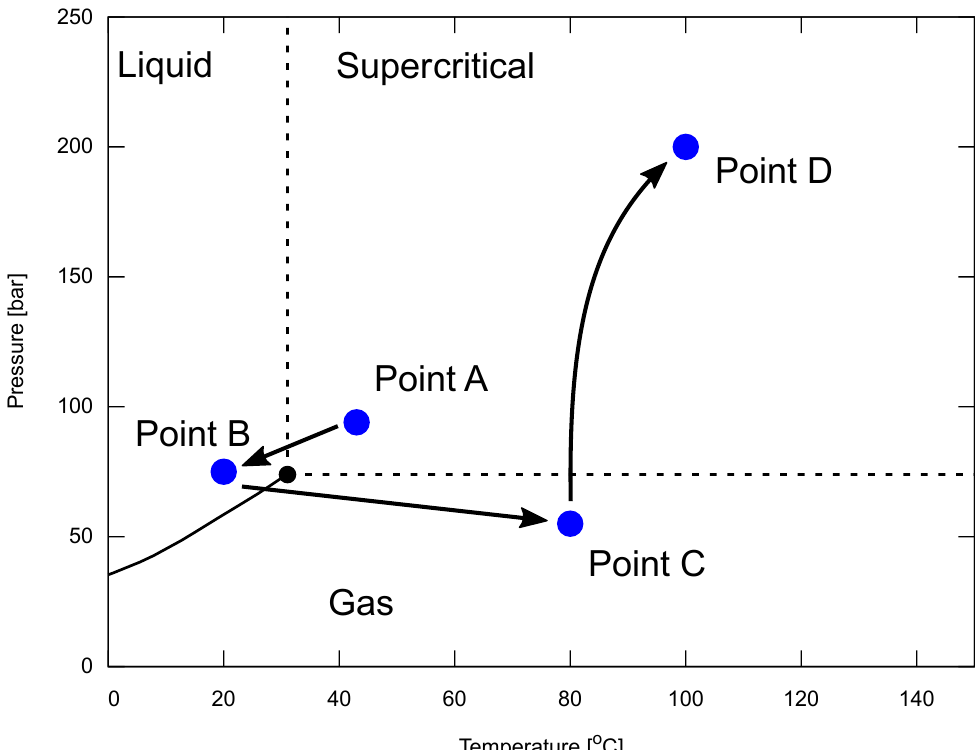
Figure 12. Example of a thermodynamic pathway from a source of CO 2 emission to subsurface reservoirs as a sink, shown in a pressure, P , and temperature, T , phase diagram of CO 2 . Point A represents the conditions after compression at a capture site. Point B represents a wellhead condition of a CO 2 injector. Point C represents a downhole condition at the beginning of CO 2 injection in a depleted gas reservoir. Point D represents a reservoir condition at the end of the CO 2 injection. The change from points B to C is discussed in Appendix B, while the change from points C to D is discussed in Appendix C. This figure is modified from Hoteit et al.